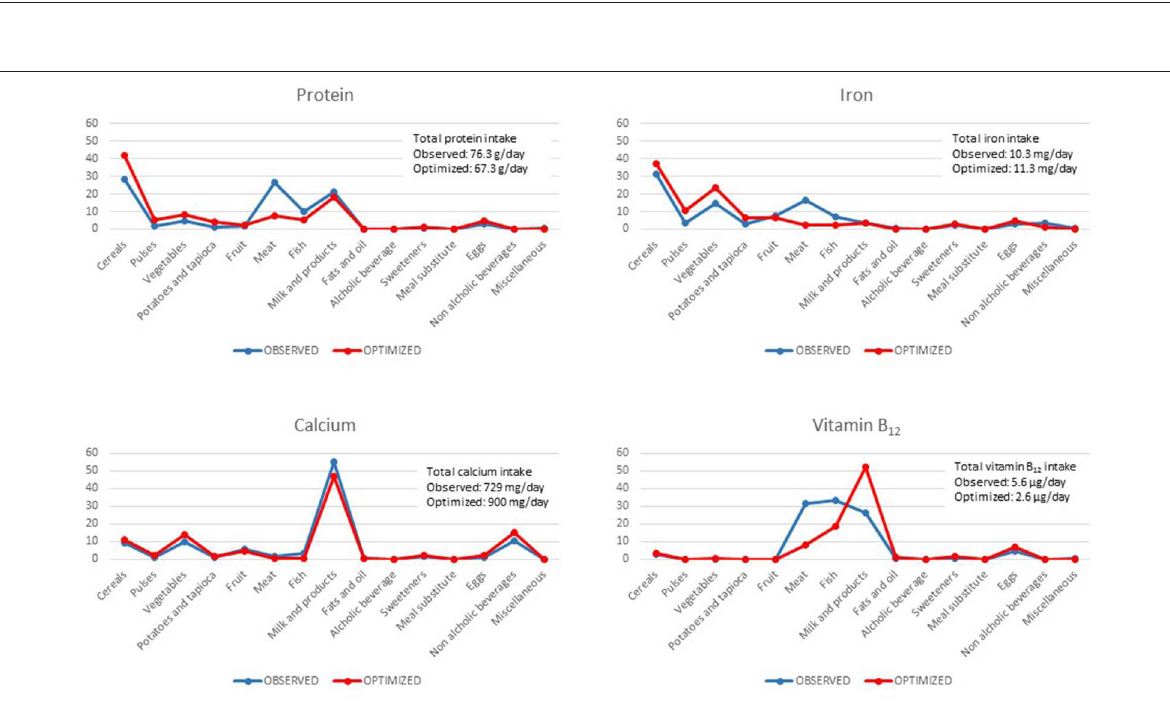
Frontiers in Nutrition |